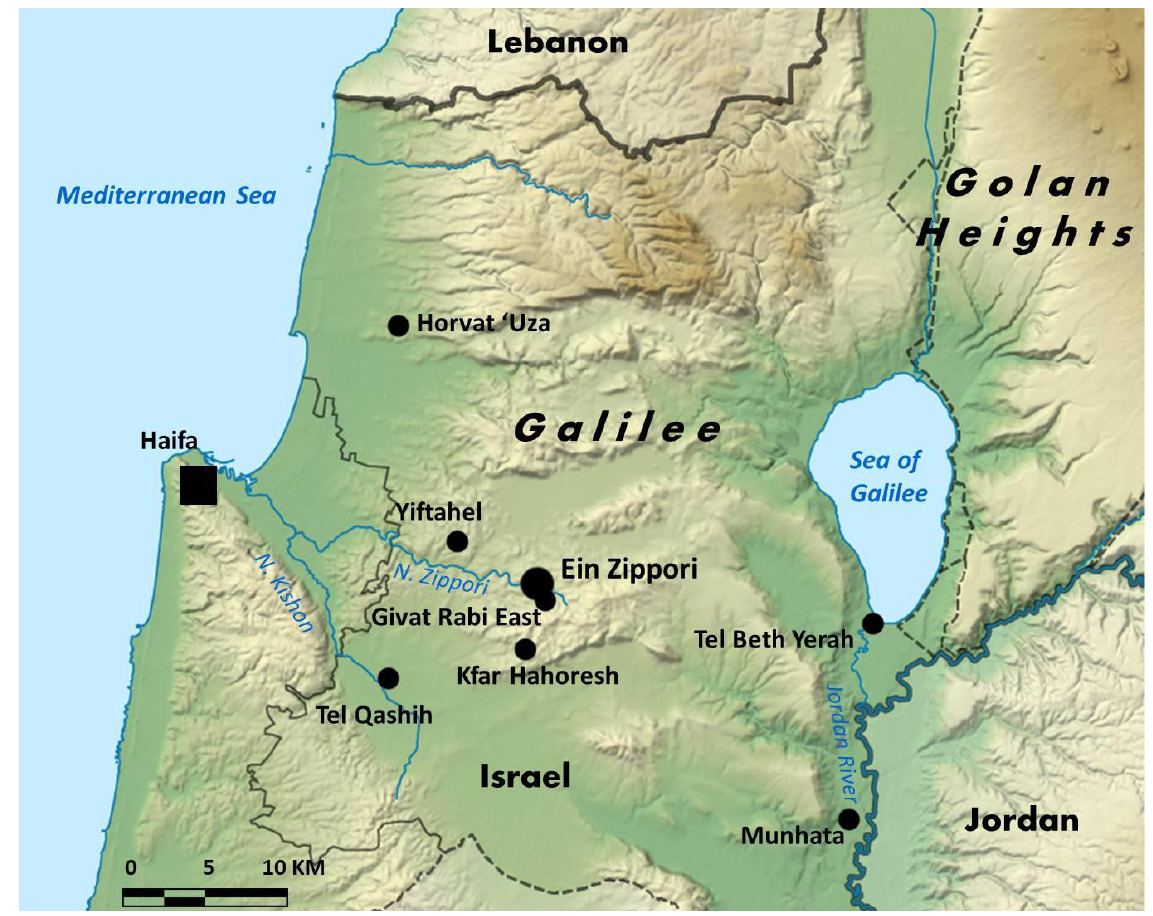
Figure 1. Location of the site of